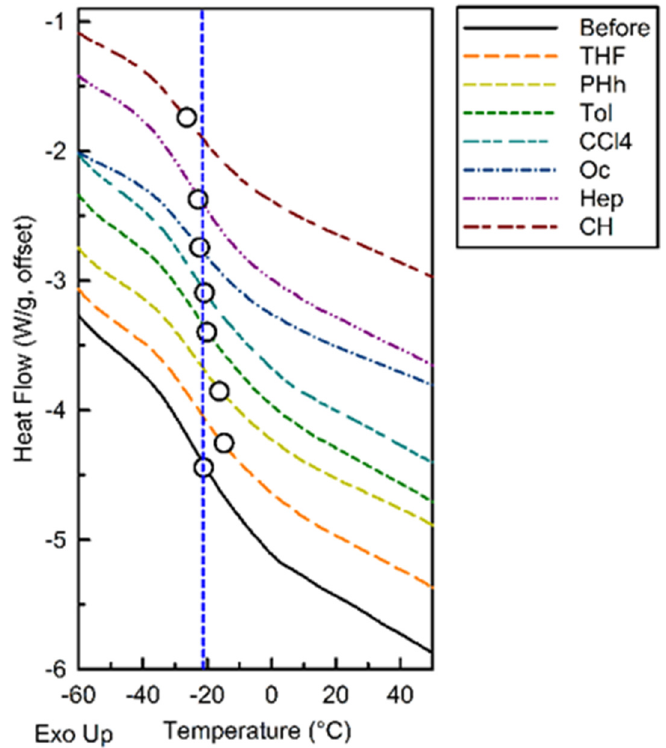
Figure 8. DSC curves of adhesive before and after different solvent dissolution and evaporation. Glass transition temperature (Tg) was marked with a circle.